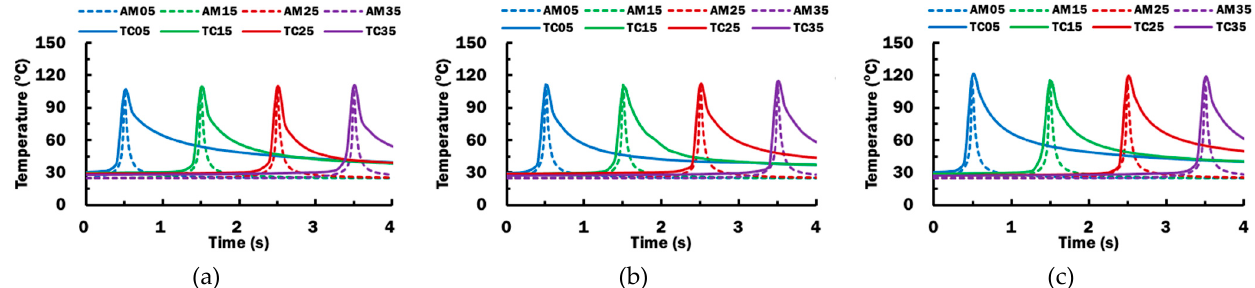
Figure 13. Temperature histories measured at locations of thermocouples TC05, TC15, TC25, and TC35 during the end of deposition from heat transfer FEAs for different printing temperatures: ( a ) T p = 230 °C; ( b ) T p = 240 °C; ( c ) T p = 250 °C.